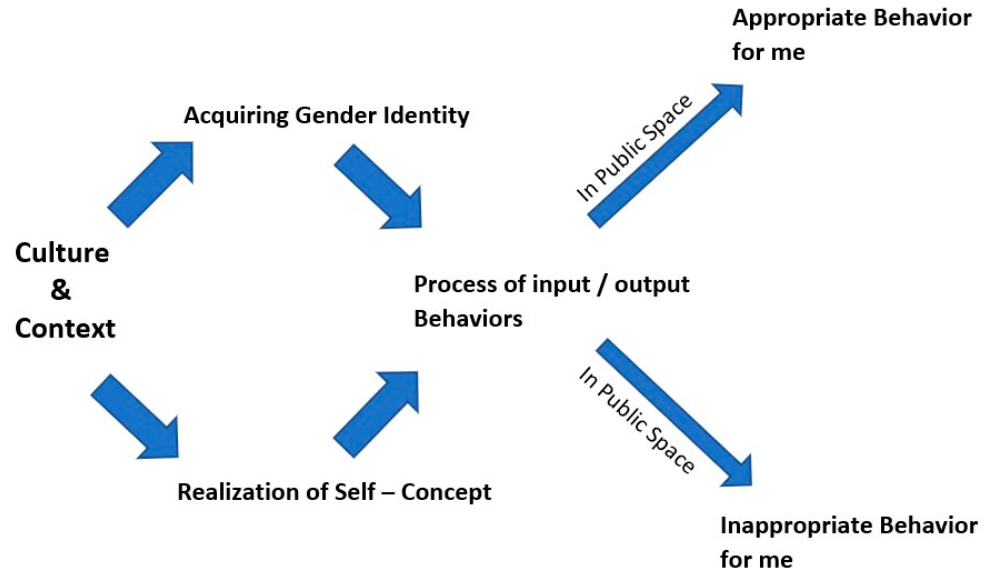
Figure 3. Social cognitive theory in action: a diagram of acquiring appropriate behaviors in public space. Adapted from Shaffer and Kipp [91].